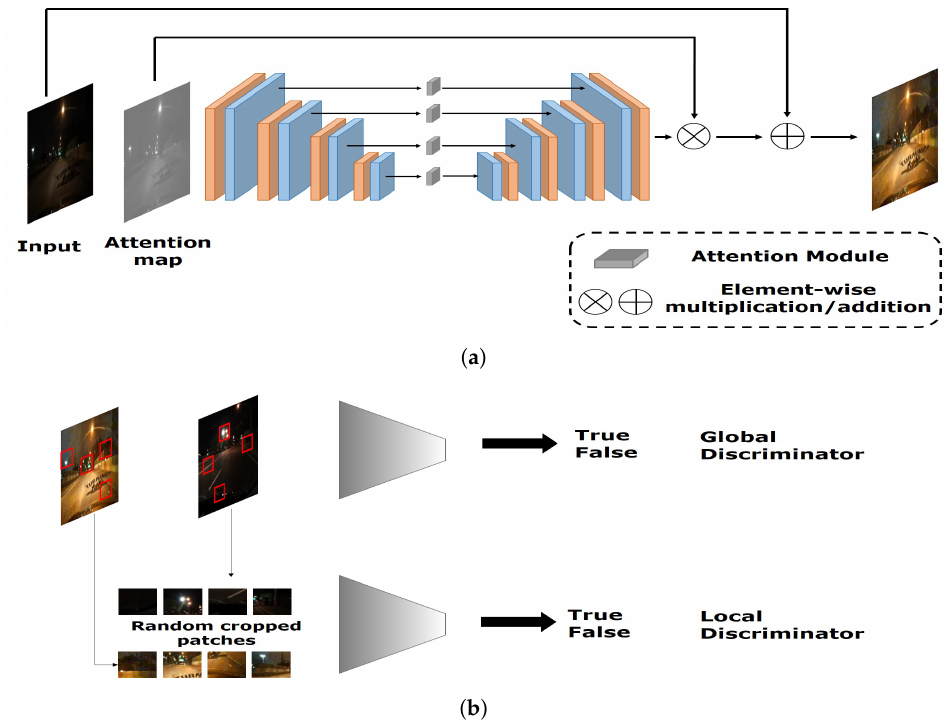
Figure 8. Architecture of EnlightenGAN framework: ( a ) generator and ( b )